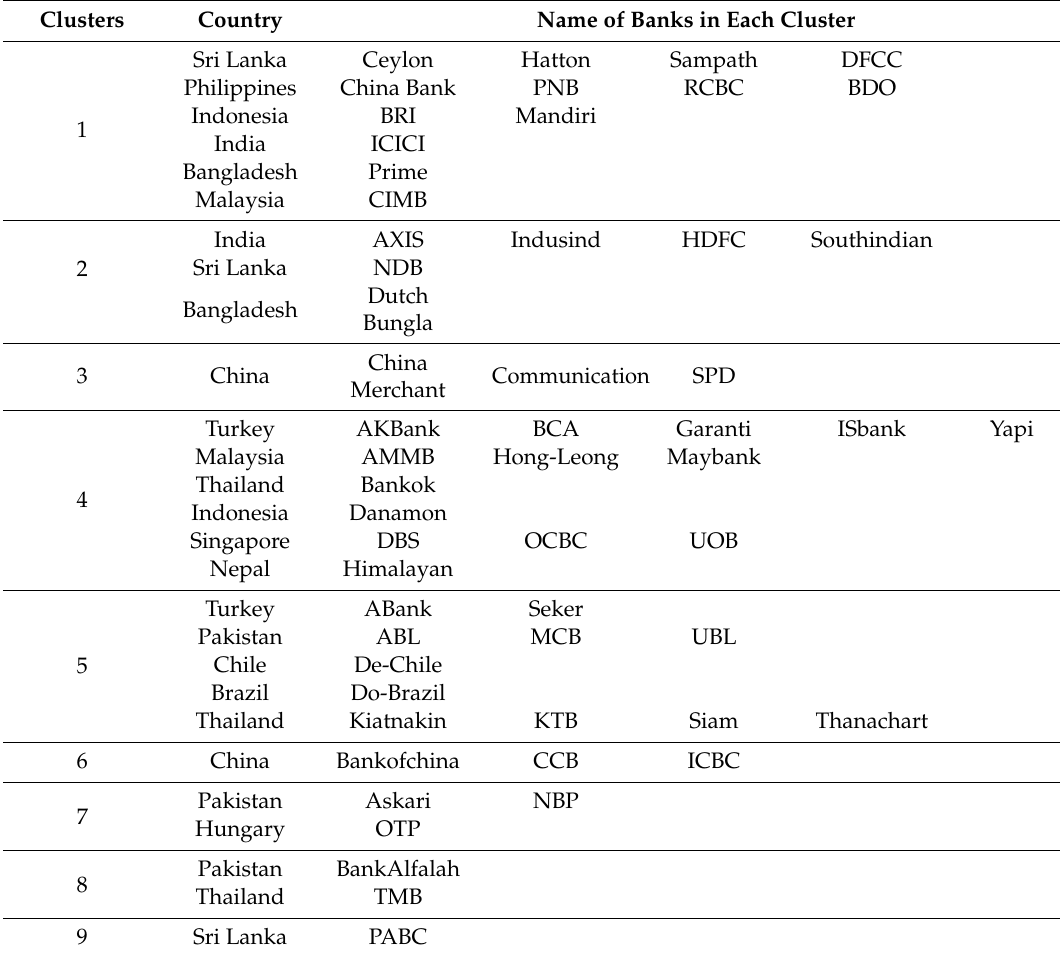
Table 6. List of Banks in Each